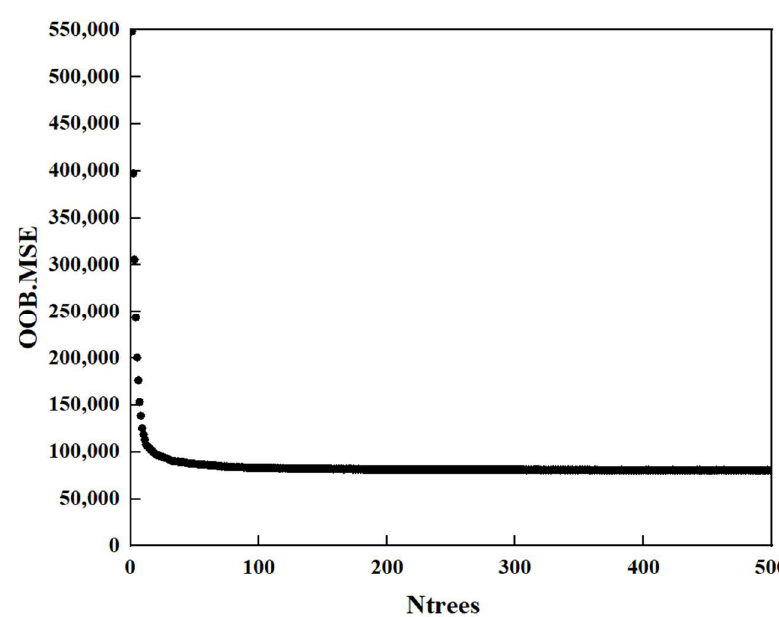
Figure 3. Relationship between Ntrees and OOB.Error.